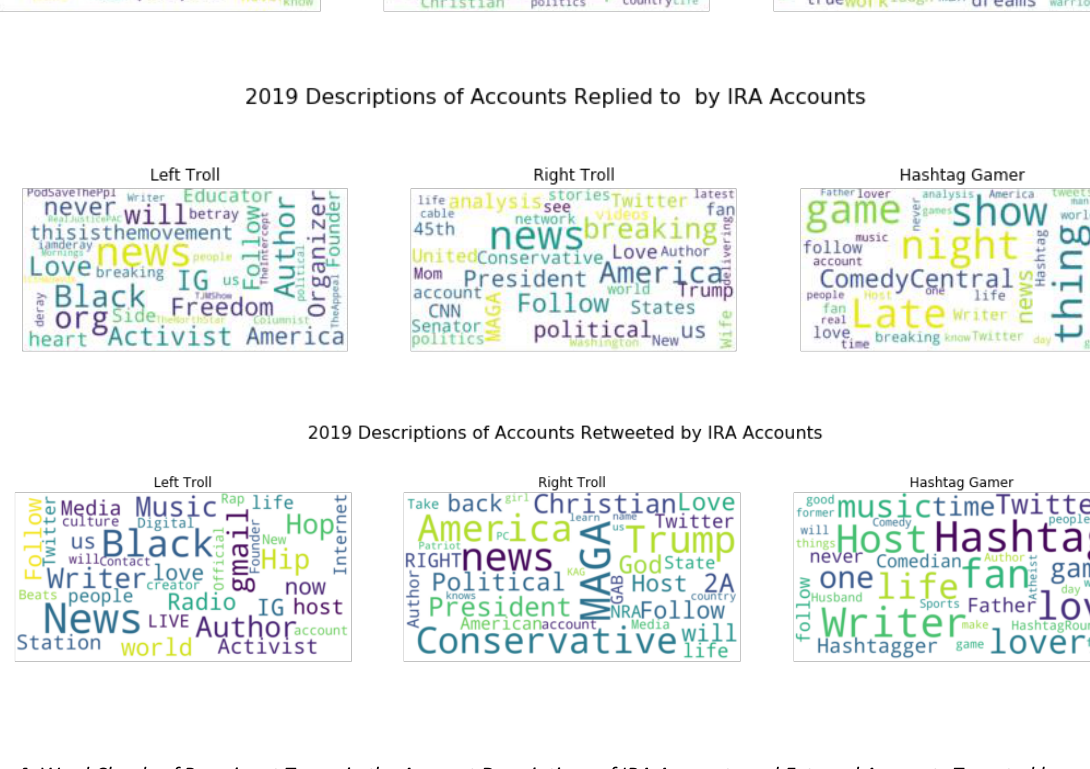
Figure 4. Word Clouds of Prominent Terms in the Account Descriptions of IRA Accounts and External Accounts Targeted by External Output of the IRA